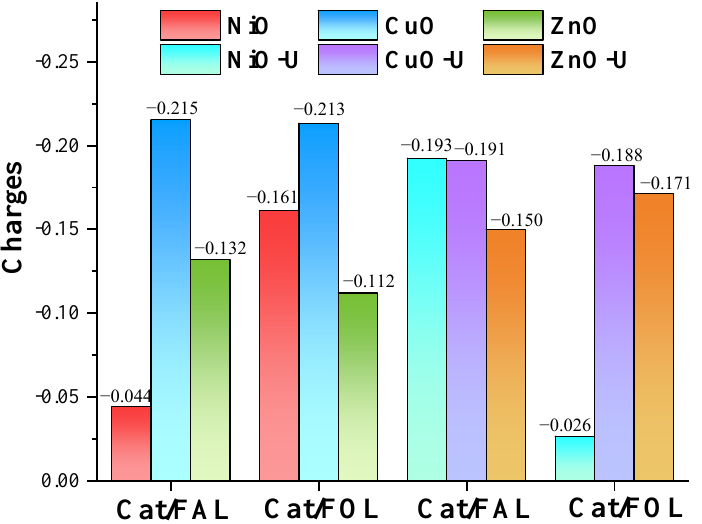
Figure 4. Mulliken charges of the catalyst fragment in intermediates Cat/FAL and Cat/FOL. The charge value of nickel-based catalysts was very sensitive to hydrogenation and doping. The difference before and after hydrogenation was up to 0.167, while that before and after doping was up to 0.149. The sensitivity of nickel-based catalysts indicates that hydrogenation and doping significantly changed its electrostatic interaction strength with furfuryl alcohol/furfural, thereby significantly affecting the binding stability. For NiO complexes, the charge after hydrogenation of the adsorbed furfural increased significantly, from − 0.044 to − 0.161. Obviously, the electrostatic attraction of NiO with furfuryl alcohol was stronger than that with furfural. This led to a decrease in the energy of NiO/FOL , consistent with our calculated thermodynamics. Using NiO-U catalyst, the charge on the catalyst part after hydrogenation was significantly reduced, from − 0.193 to − 0.026, reflecting a weakened electrostatic attraction, thereby explaining the increased Gibbs energy of NiO-U/FOL compared with NiO-U/FAL